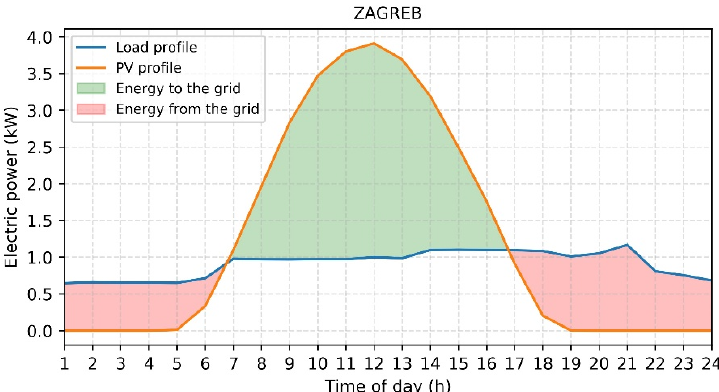
Figure 5. Electrical energy balance between household and power grid according to the net- metering model.